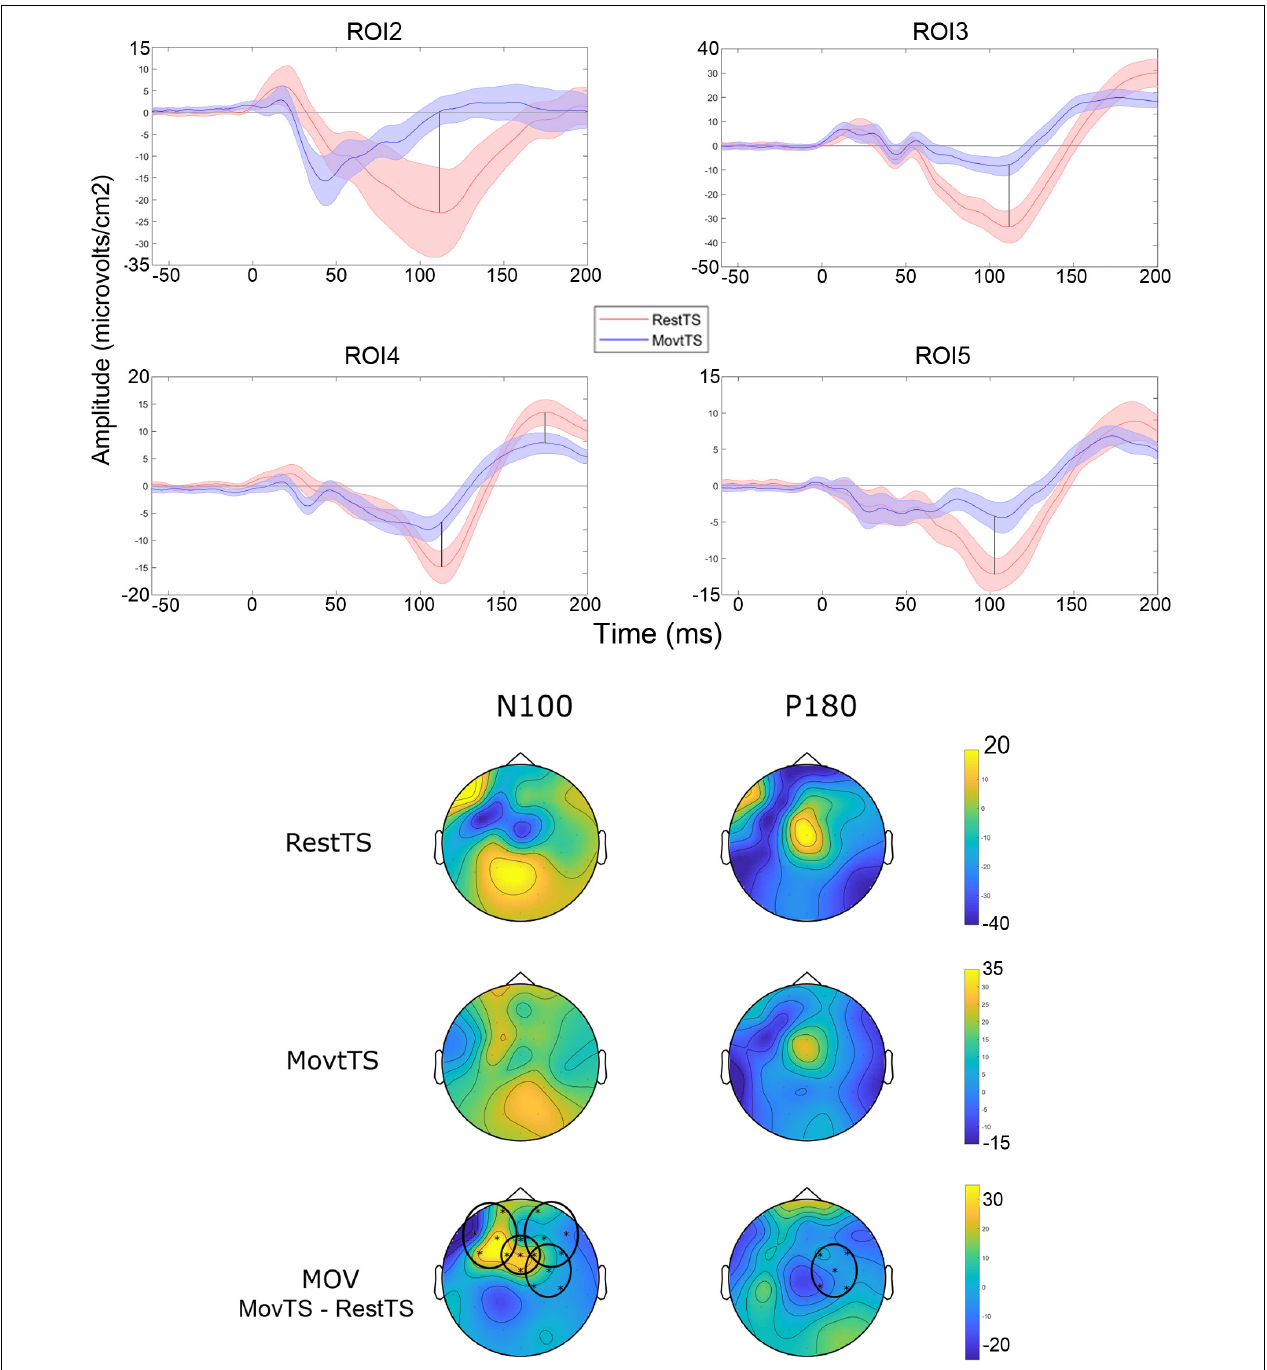
FIGURE 6 | Movement related modulation of TEPs. Upper panel: Averaged TEP in ROIs that showed significant differences between RestTS (red) and MovtTS (blue) (mean ± SE). N100 was significantly modulated at movement onset in ROI2, 3, 4, and 5, while P180 was modulated in ROI4 (vertical lines). Lower panel: topographic representation of current source density (CSD) for N100 and P180 at RestTS (first row), MovtTS (second row), and the effect of movement onset (MOV, expressed as MovTS – RestTS) (third row). ROIs significantly modulated by MOV are highlighted (yellow, positive values; blue, negative values).